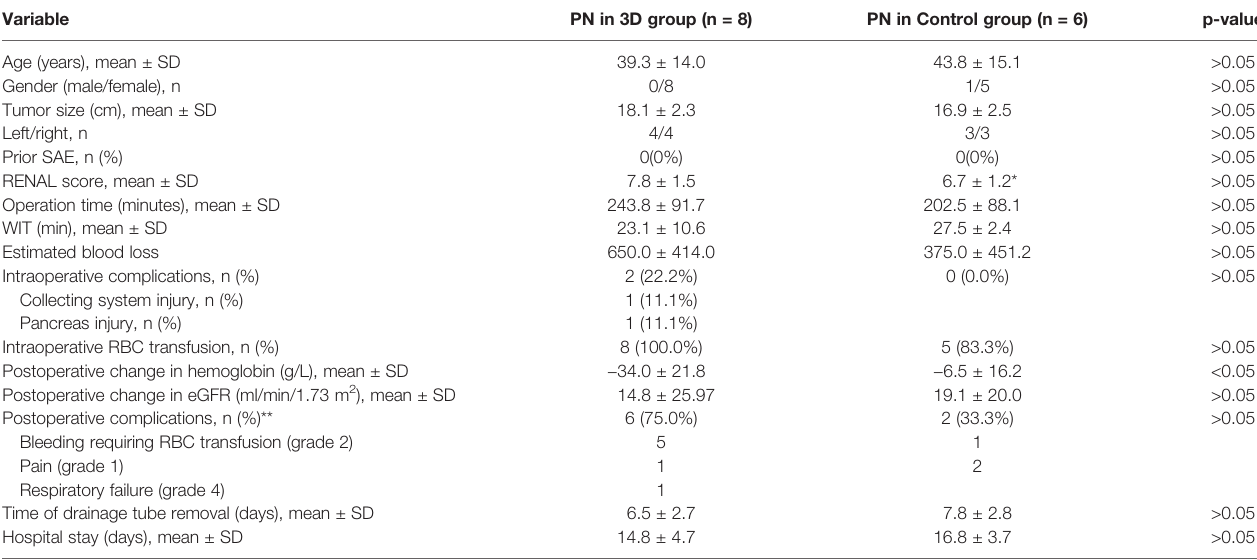
TABLE 4 | Subgroup analysis of perioperative parameters and clinical outcomes.